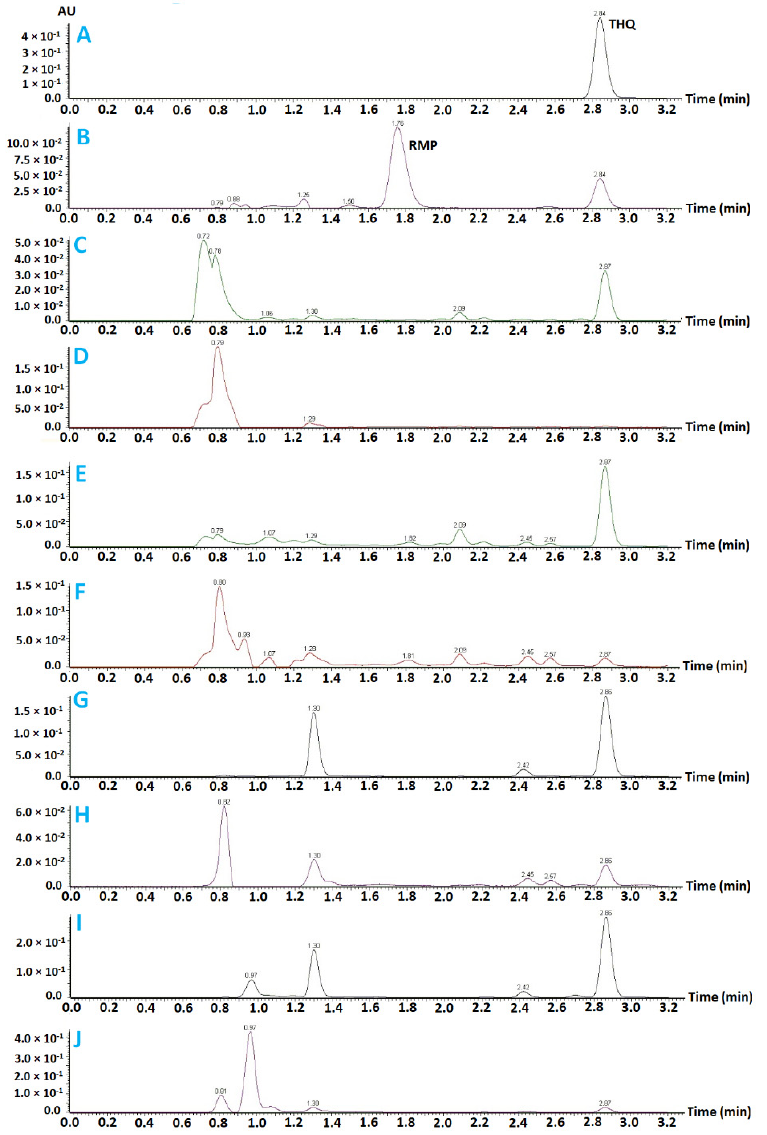
Figure 1. Forced degradation studies of THQ and RMP. ( A ): represents freshly prepared standard THQ solution (41.4 ppm), ( B ): freshly prepared standard RMP solution (50 ppm), ( C ): THQ acid hydrolysis, ( D ): RMP acid hydrolysis, ( E ): THQ base hydrolysis, ( F ): RMP base hydrolysis, ( G ): THQ thermal degradation, ( H ): RMP thermal degradation, ( I ): THQ oxidative degradation, and ( J ): RMP oxidative